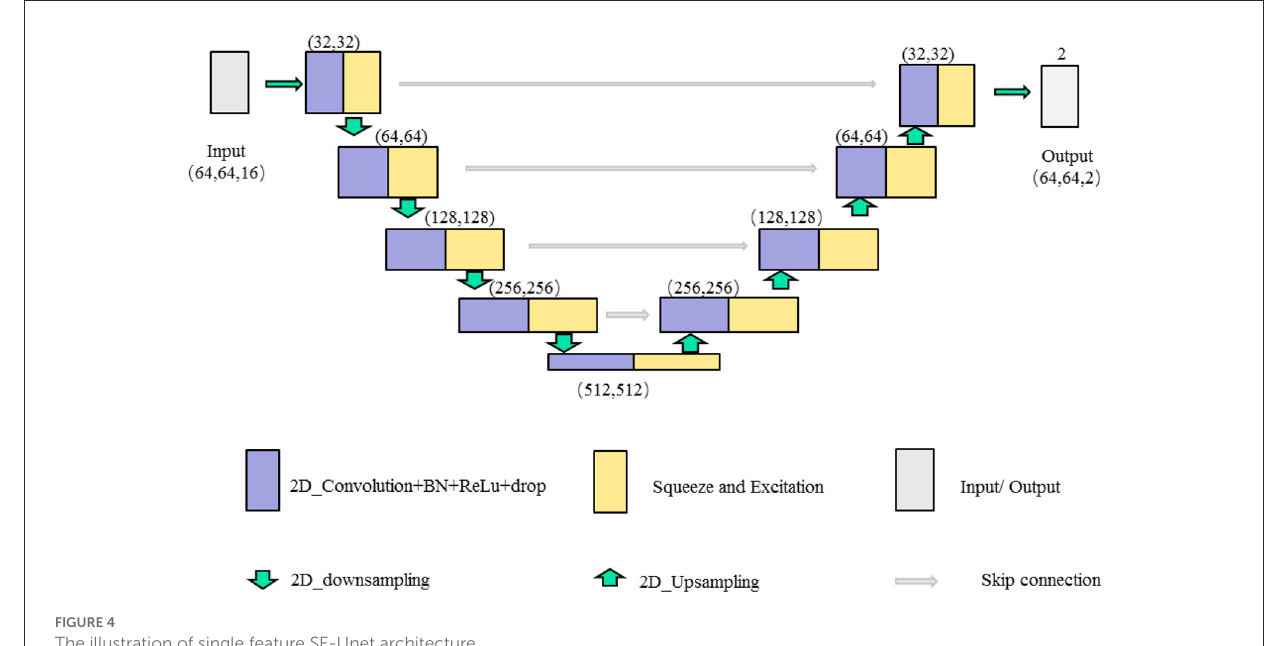
FIGURE4 The illustration of single feature SE-Unet architecture.